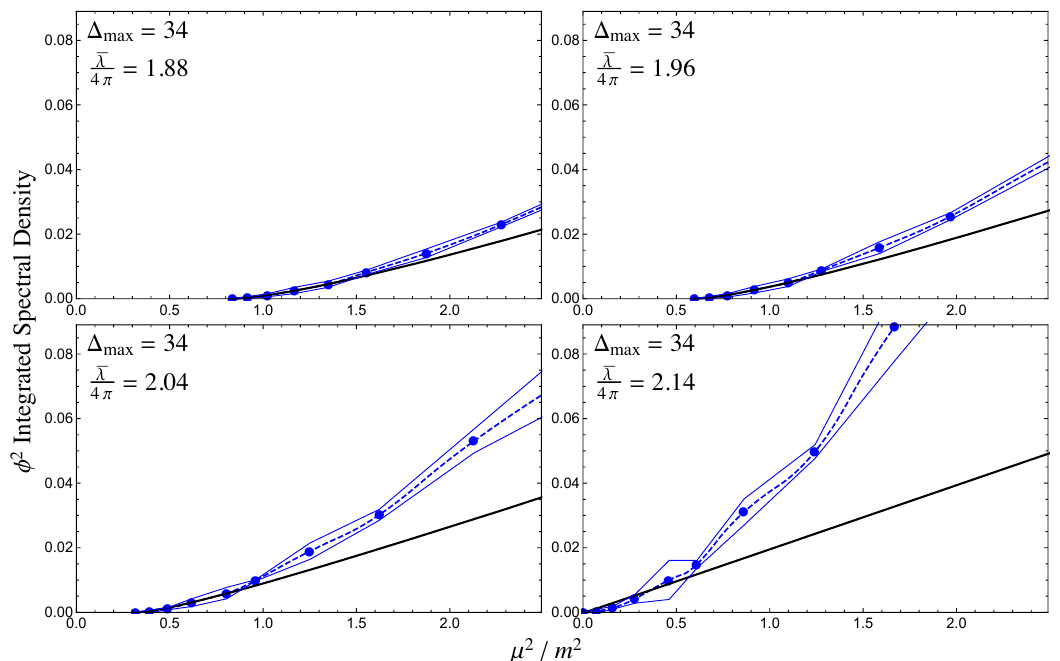
Figure 10 . Integrated spectral densities for (cid:30) 2 , for (cid:1) max = 34 and di(cid:11)erent values of (cid:22) (cid:21) , compared to the Ising model prediction for " (black curve). The thin blue lines indicate the magnitude of the di(cid:11)erence between these results and those at (cid:1) max = 30, providing a rough estimate of the convergence. For reference, the upper right plot corresponds to the same value of the coupling ( (cid:22) (cid:21) = 1 : 96) as (cid:12)gures 8 and 4 (cid:25)